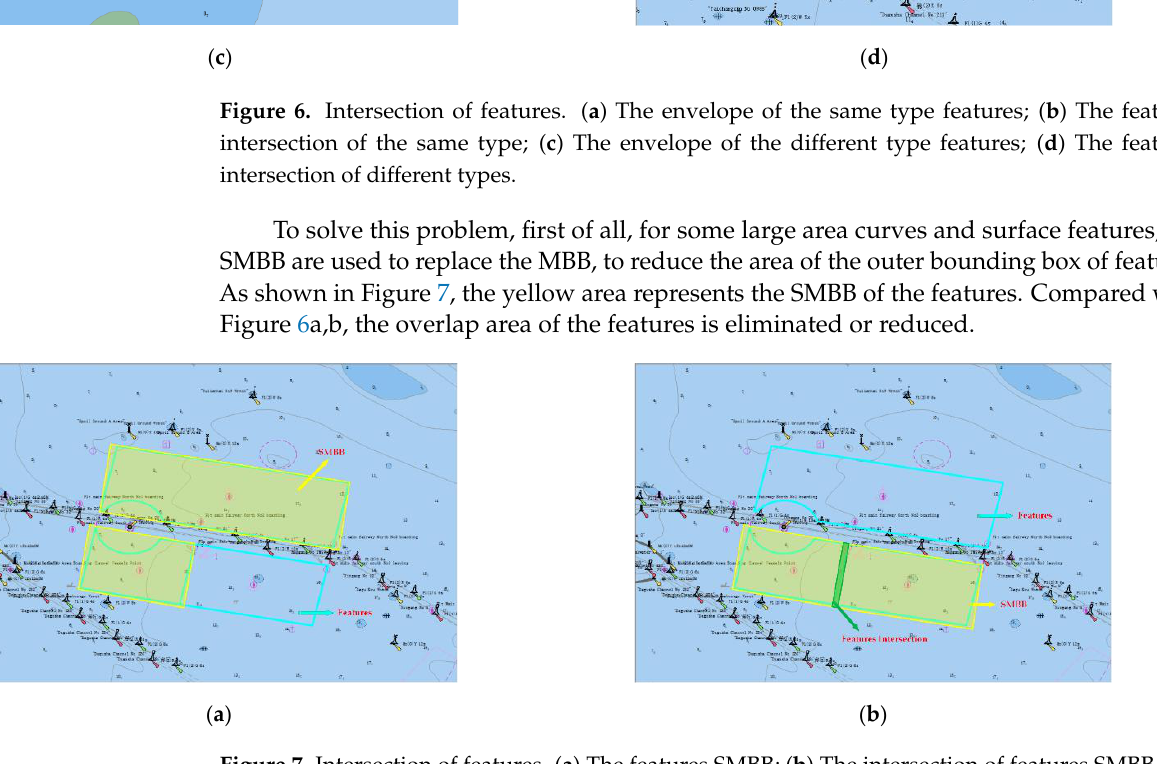
Figure 7. Intersection of features. ( a ) The features SMBB; ( b ) The intersection of features SMBB. The calculation of the SMBB uses the rotary clamping algorithm, and the algorithm is implemented as